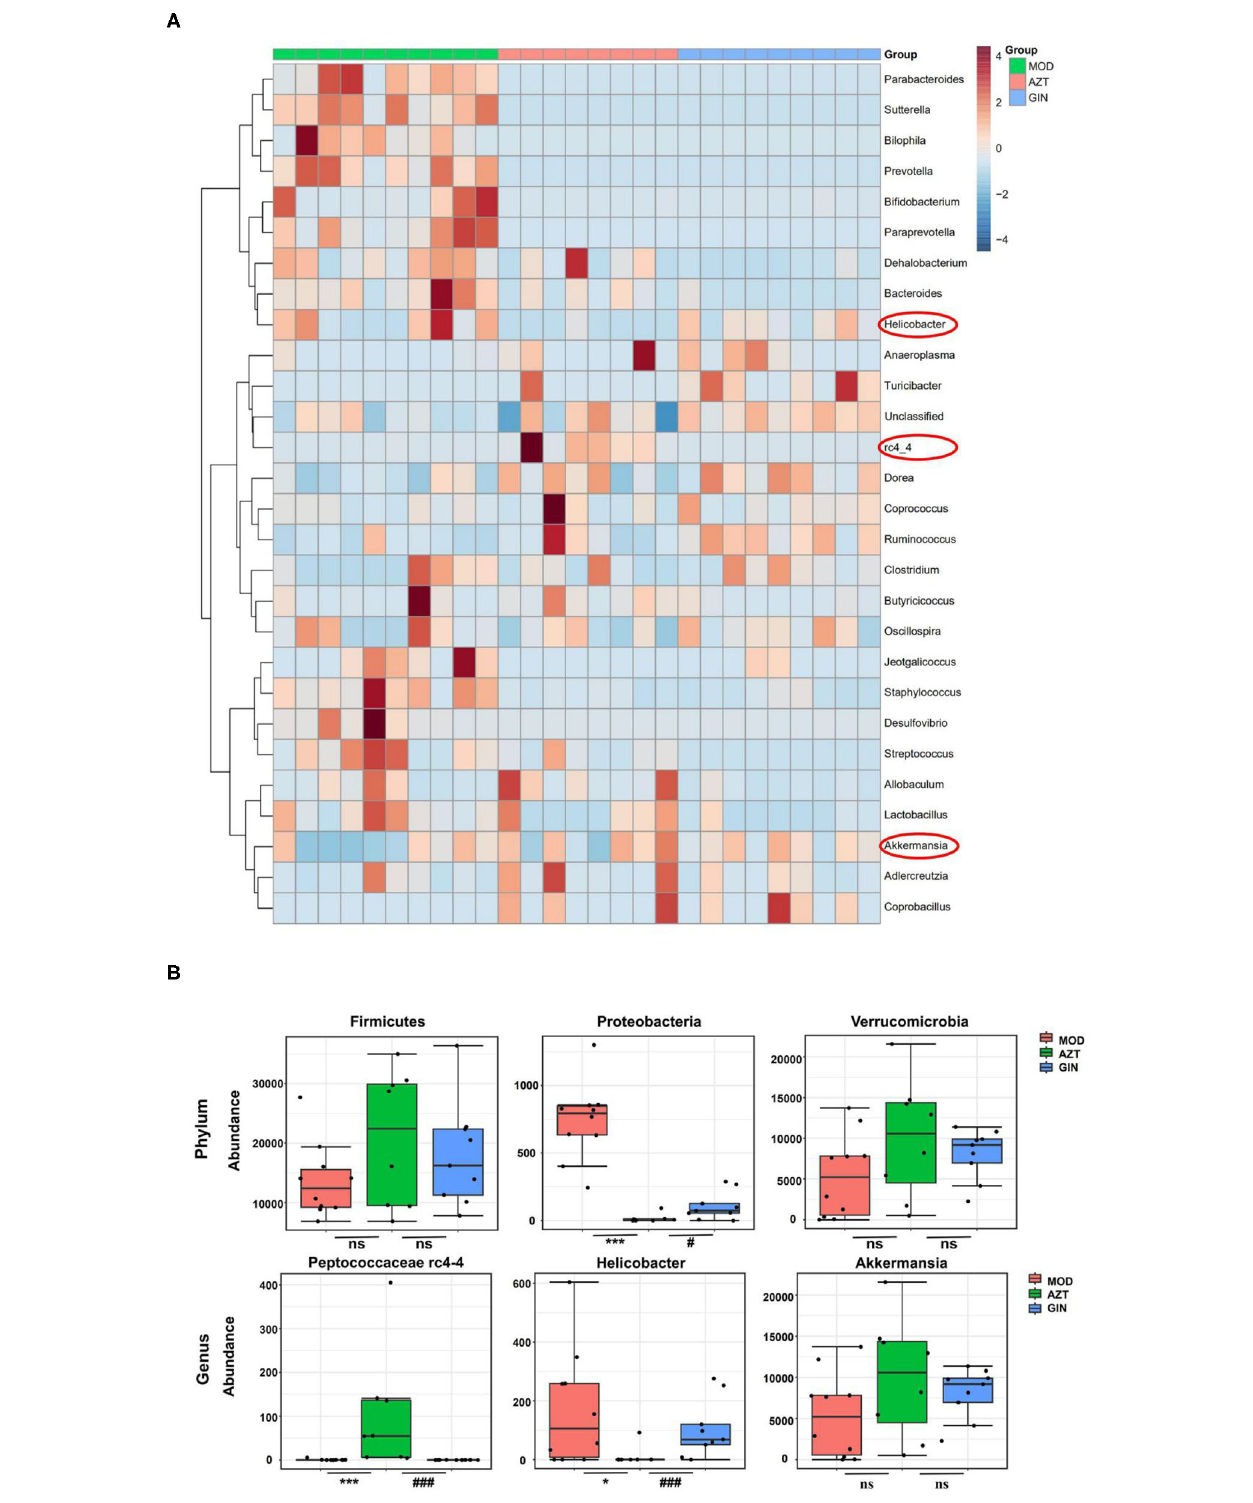
FIGURE 7 | Ginger modulates the composition of gut microbiota induced by early AZT exposure. (A) Heatmap of the relative abundance of key 27 OTUs altered by AZT and ginger at genus level. (B) The relative abundance of microbial species at phylum and genus level. * p < 0.05 and *** p < 0.01 vs. MOD group; # p < 0.05 and ### p < 0.01 vs. AZT